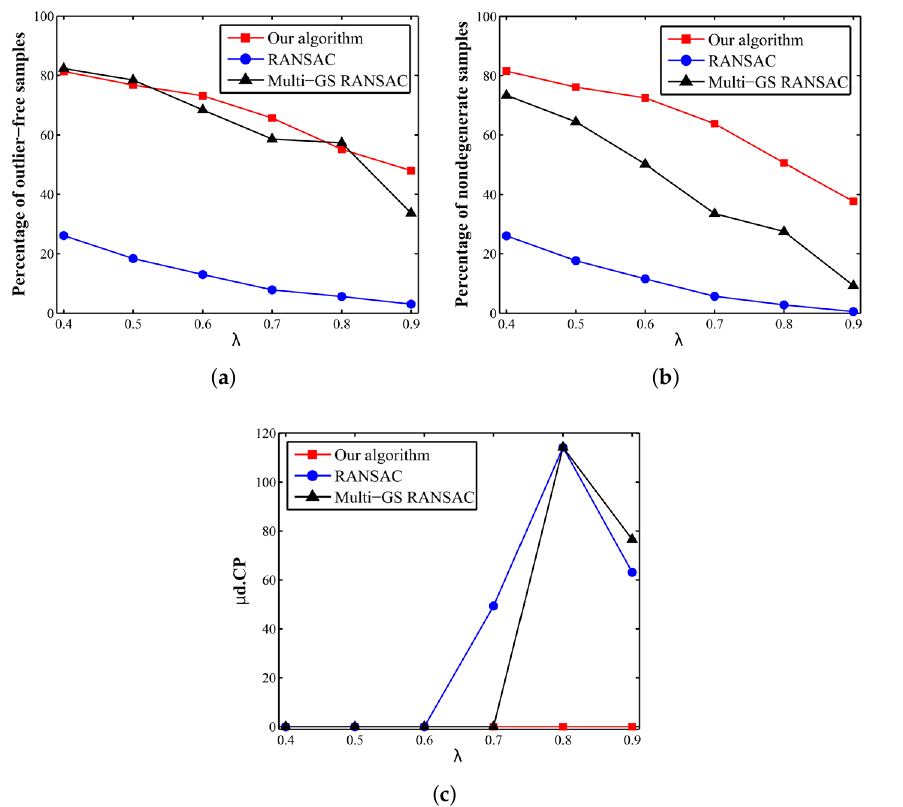
Figure 4. Performance of sampling methods on the Table dataset as the ratio λ increases: ( a ) percentage of outlier-free sample sets, ( b ) percentage of non-degenerate sample sets and ( c ) estimation